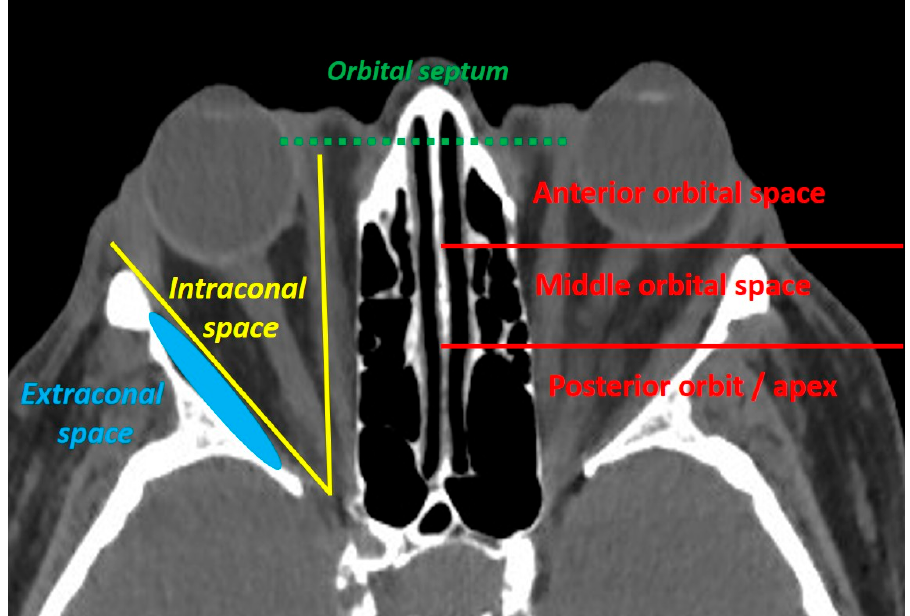
Figure 1. The orbital invasion (defined as an orbital septum violation) by an eyelid malignant tumour can be defined as intraconal (if located inside the oculomotor muscle cone) or extraconal (if located outside the oculomotor muscle cone), and should be located according to its depth (anterior, middle or posterior orbit).